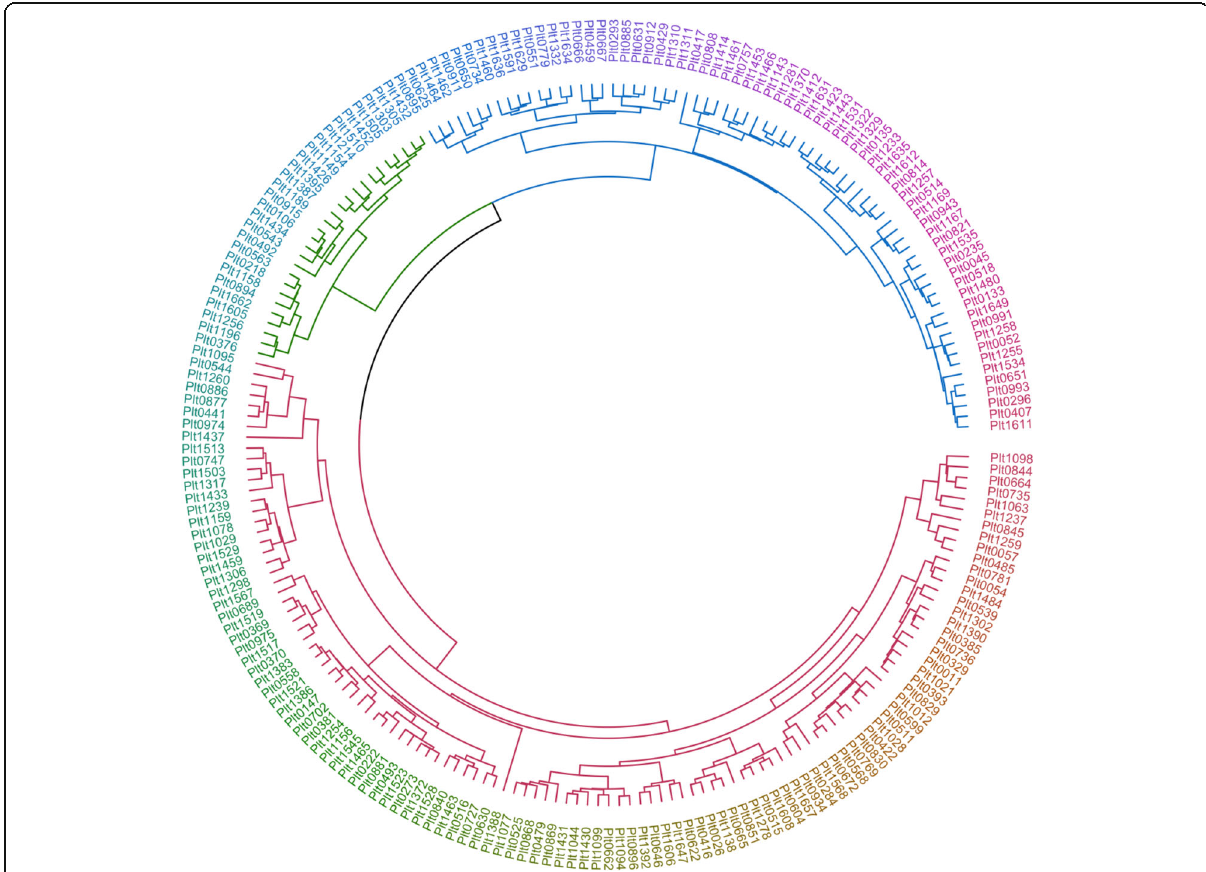
Fig. 1 Ward ’ s cluster analysis indicates that the samples ( n = 211) grouped into three clusters based on 19 grain quality attributes: n 1 = 114 (red), n 2 = 70 (blue), n 3 = 27